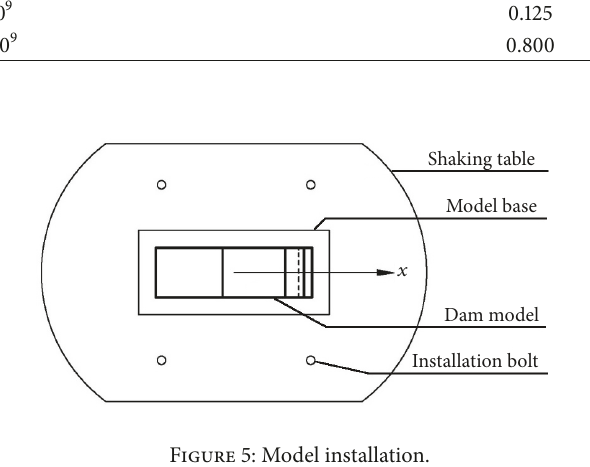
Figure 5: Model installation.